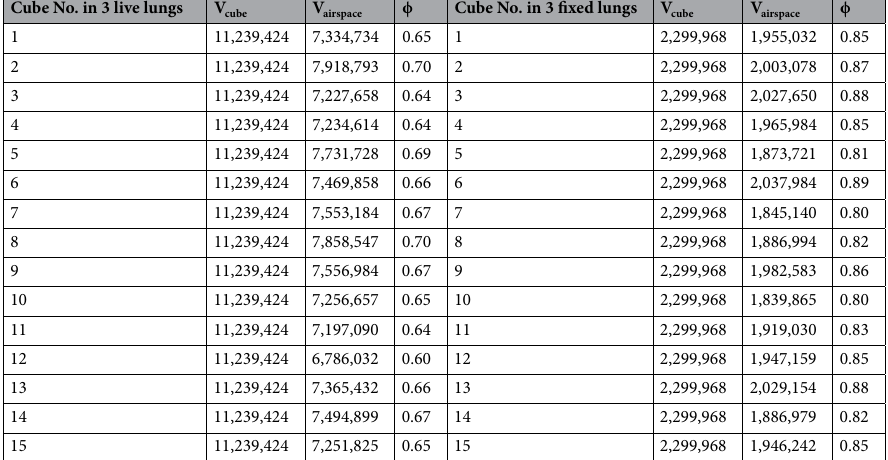
Cube No. in 3 live